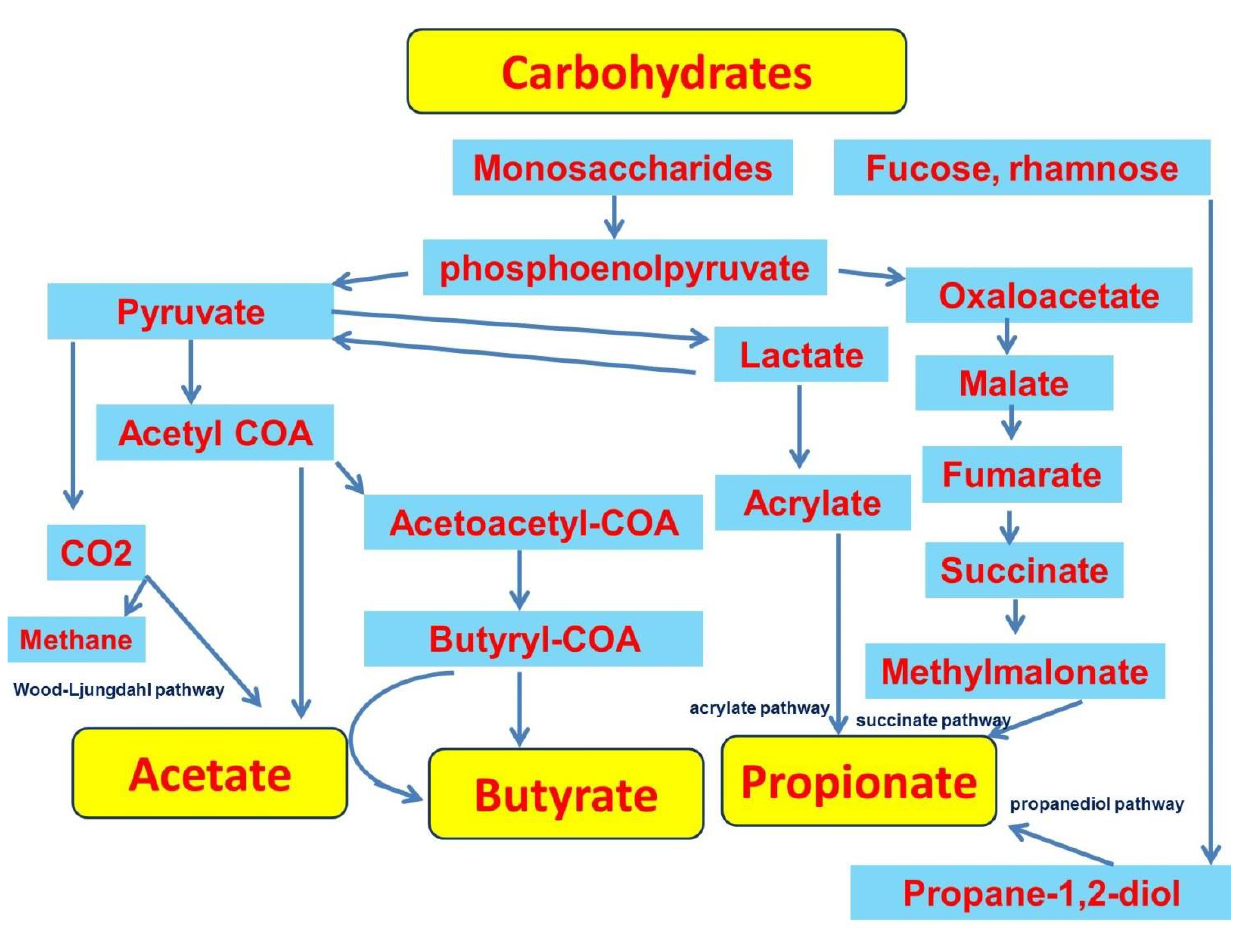
Figure 1. Short-chain fatty acids formation pathways.